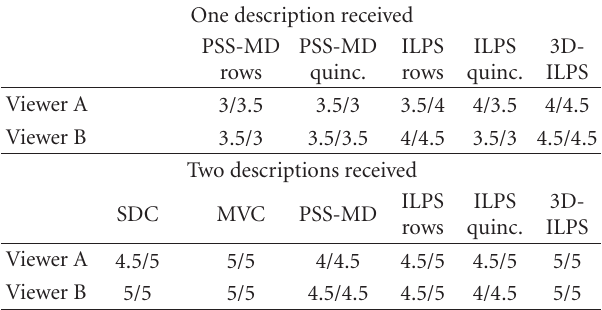
Table 5: Mean opinion Score without packet loss, Break- dance/Ballet, color view.